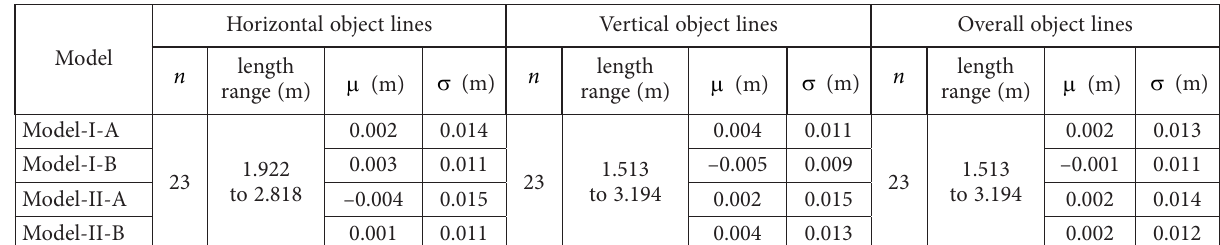
Table 7. Results for Camera-II